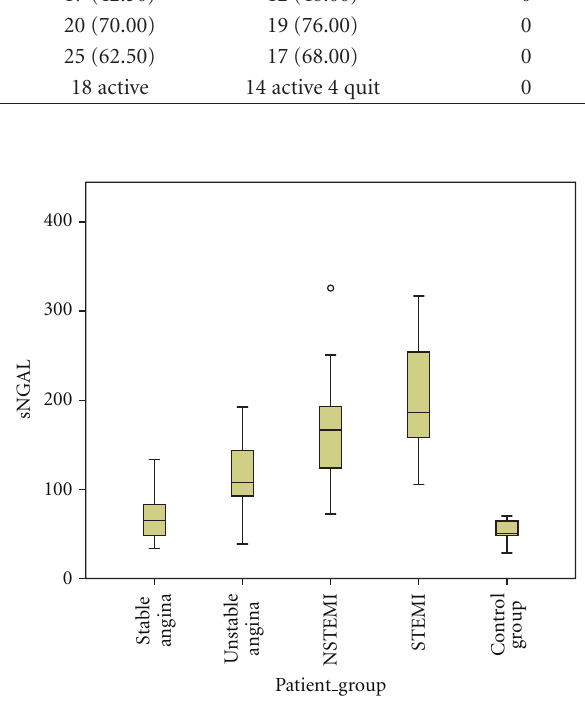
Figure 2: Box plots of median serum-NGAL values (ng/mL) among the 4 patients groups and healthy controls ( y axis is in linear